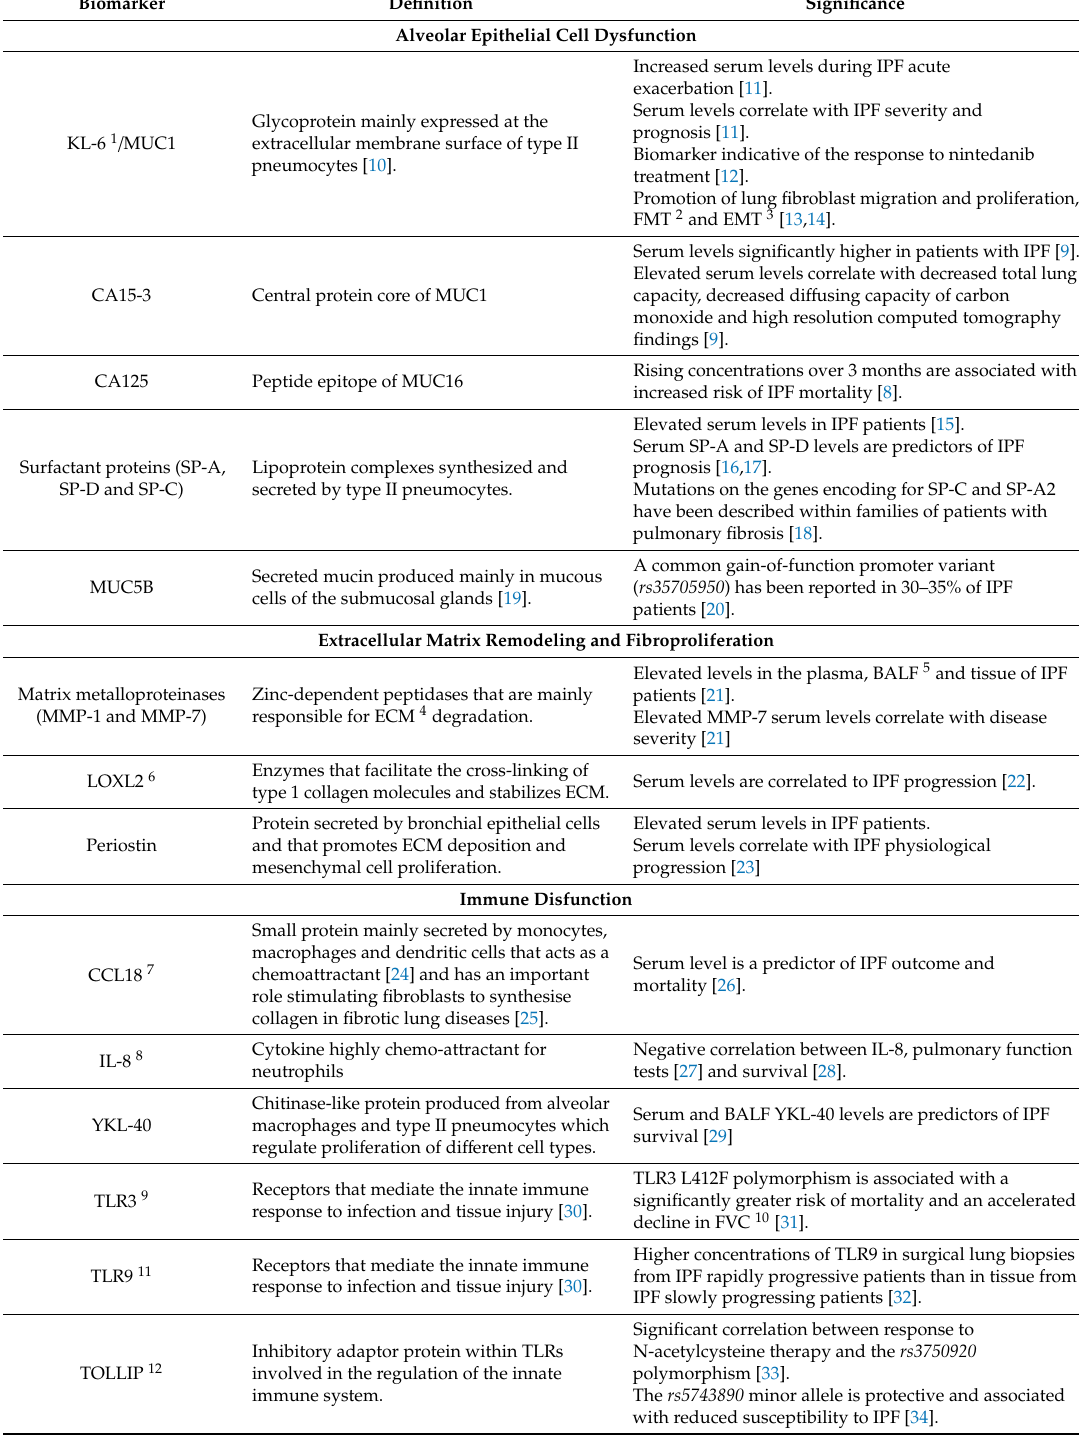
Table 1. Summary of main potential serum biomarkers in idiopathic pulmonary fibrosis